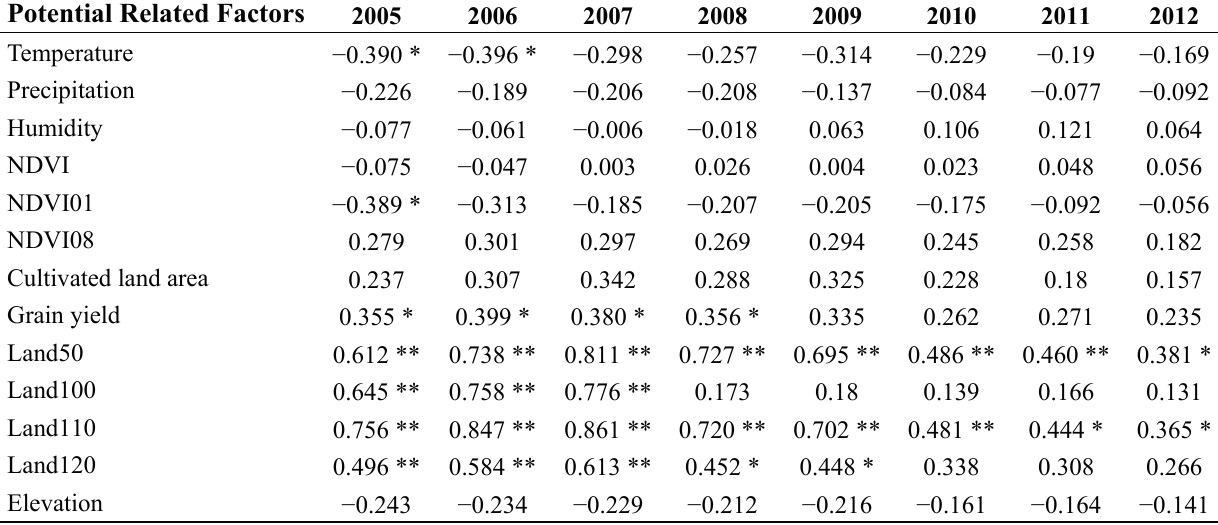
Table 2. Correlations between HFRS incidence and potential related